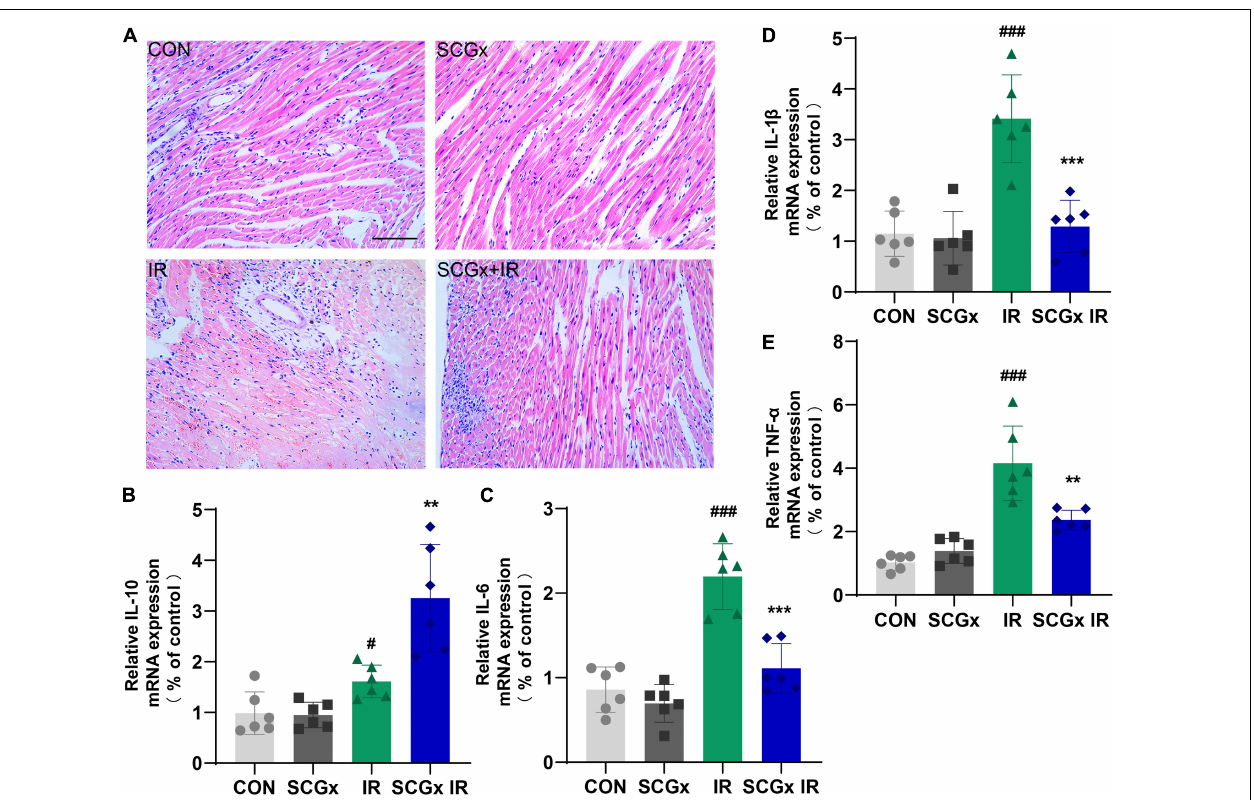
FIGURE 4 | Effect of sympathetic denervation on relative expression levels of inflammatory cytokines and pathological changes in heart tissue of myocardial I/R mice. (A) H-E staining. scale bar: 100 µ m (B–E) Determination of inflammation-related mRNAs by PCR in total RNA prepared from myocardium. interleukin-10 (IL-10) and interleukin-6 (IL-6), Interleukin-1 β (IL-1 β ), tumor necrosis factor alpha (TNF- α ). n = 6, 0.001 < ** P < 0.01 and *** P < 0.001 compared with the I/R group. # P < 0.05 and ### P < 0.001 compared with the CON